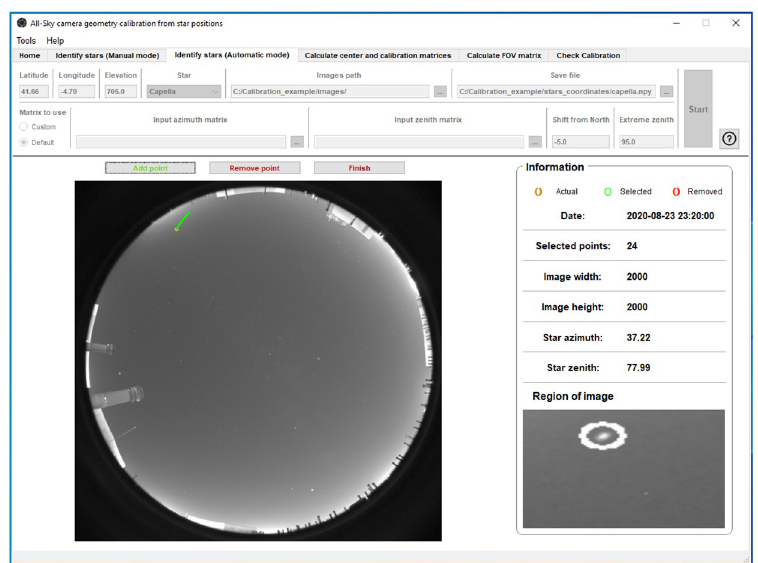
Fig 3. ORION screenshot of the star identification process in automatic mode under default matrices option. The chosen star is Capella.